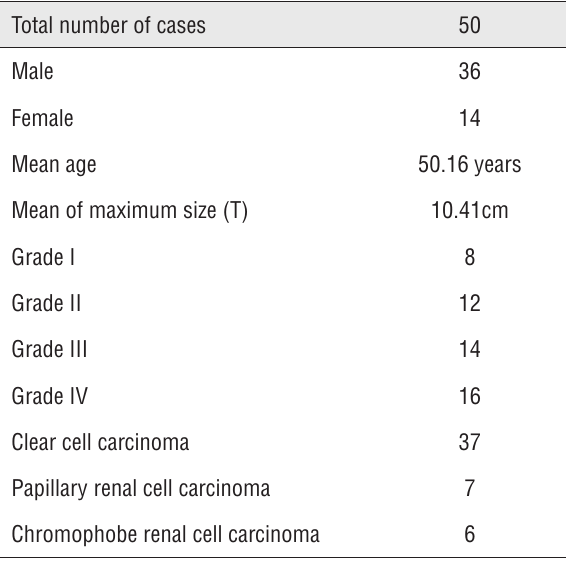
Table 1 - clinical and important histological